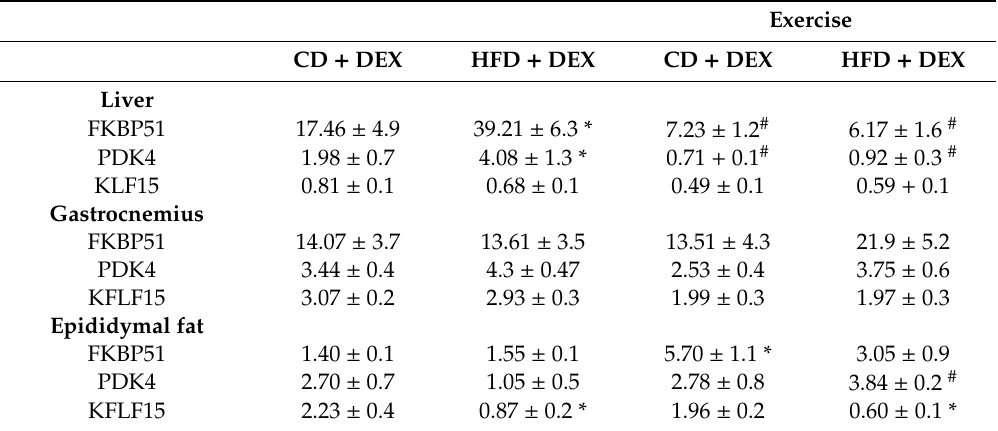
Table 2. E ff ects of moderate aerobic training in dexamethasone-induced gene expression in control- and high-fat diet-fed